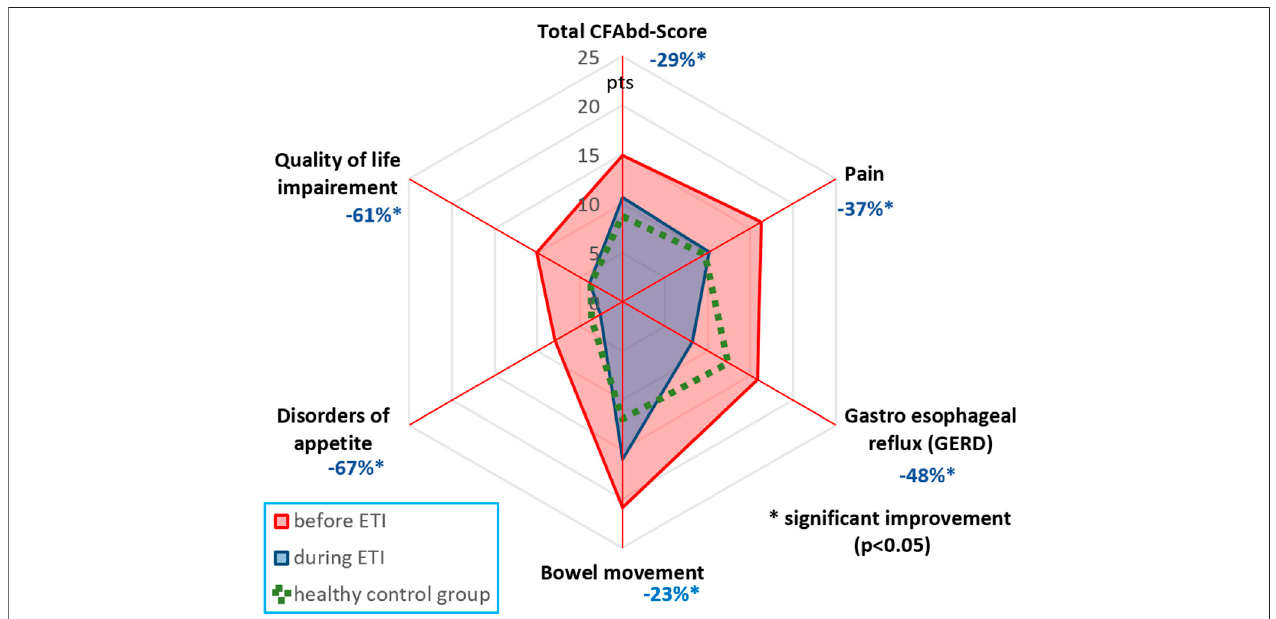
FIGURE 1 | CFAbd-Score changes for the whole cohort and its 5 domains after therapy initiation ( Table 1 ). Percent changes are calculated from estimated marginal means (EMMs) at week 24 of ETI therapy.